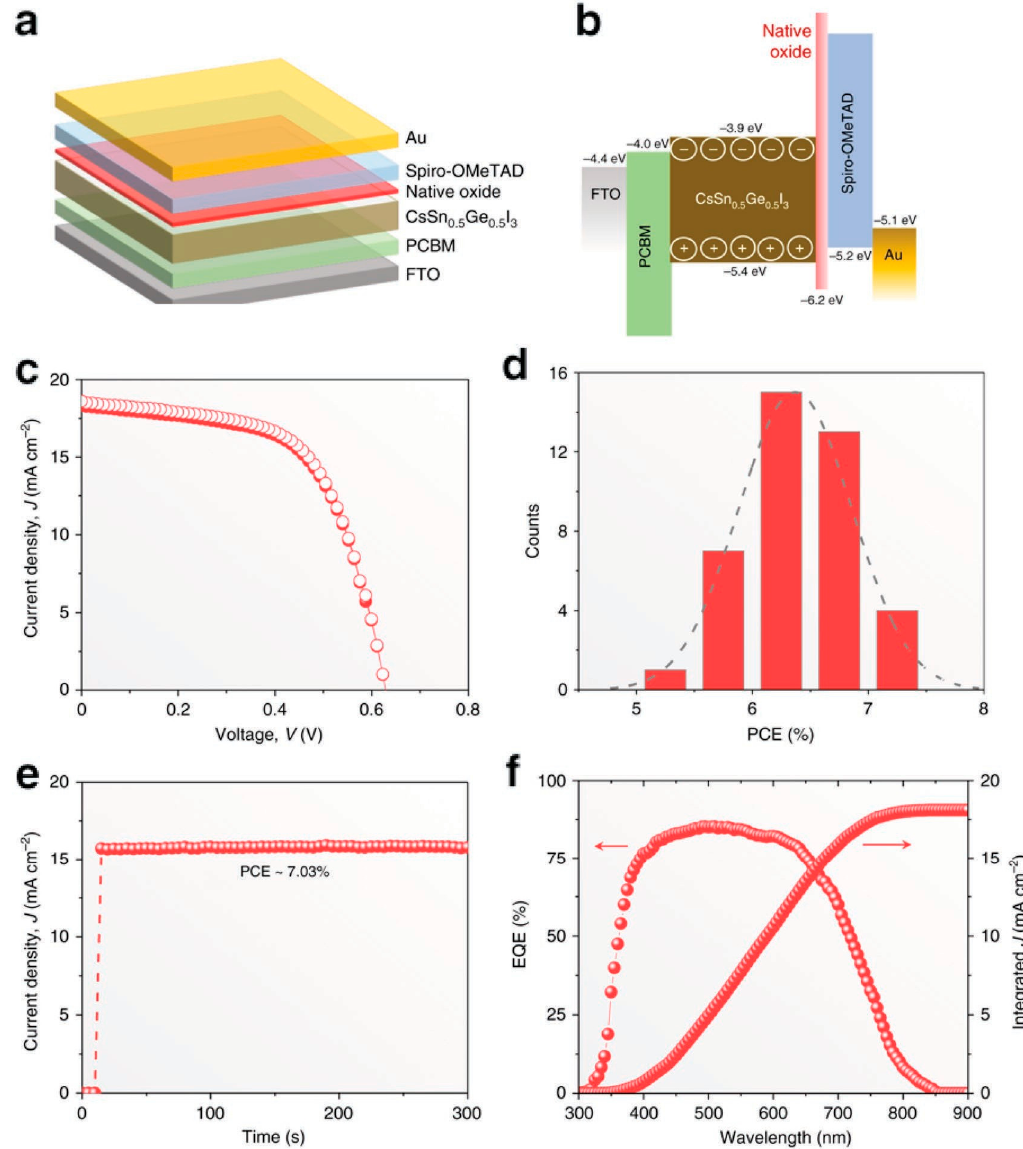
Ge I thin ‐ film PSC; ( b ) Diagram of its 0.5 0.5 3